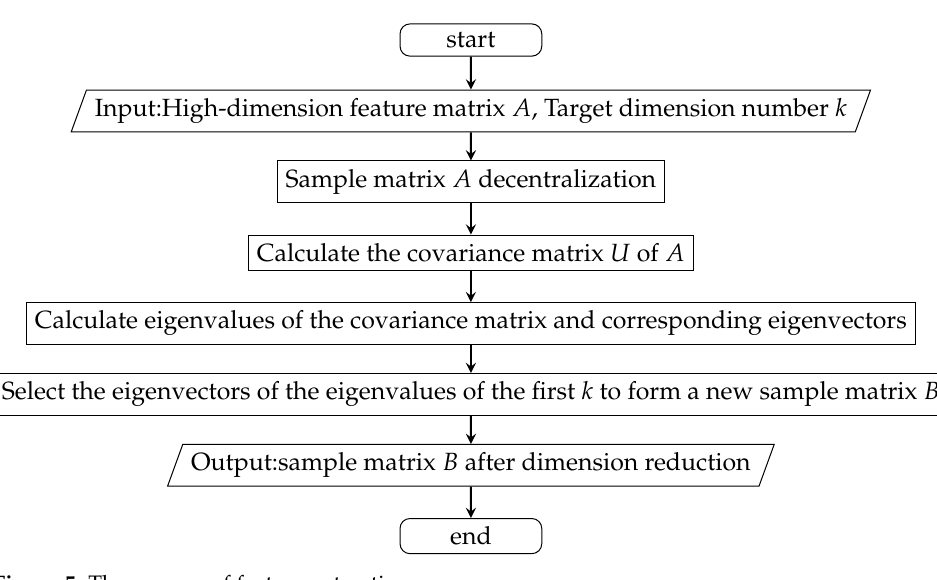
Figure 5. The process of feature